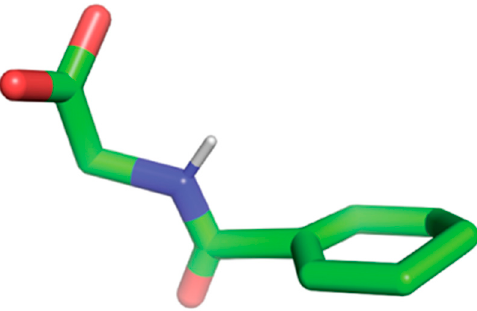
Figure 7. 3-Dimensional structure of Hippuric Acid (HA) obtained from PubChem database. Only polar hydrogens are displayed.